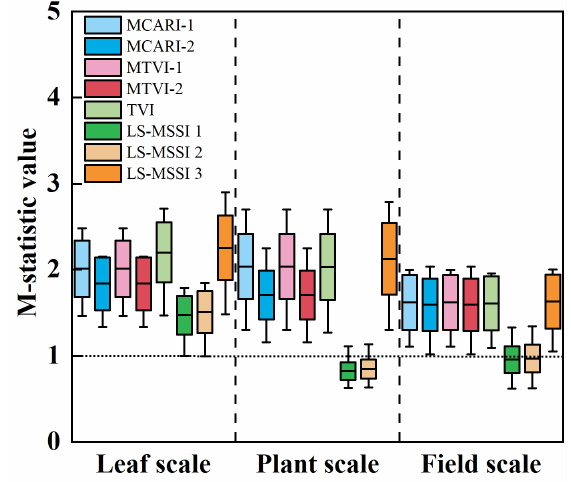
Figure 9. M-statistic values of the significantly correlated SIs.